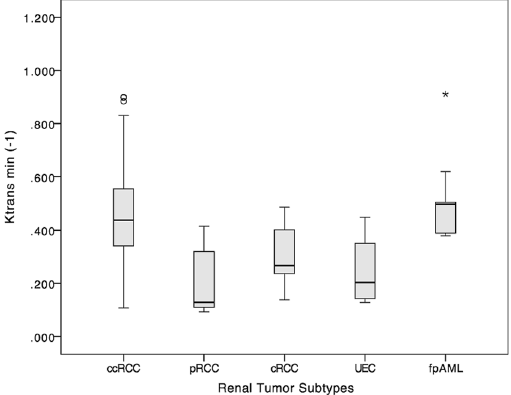
Figure 3. Box-and-whisker plot of K trans value. Boxes = interquartile range, whiskers = range of all values, horizontal line within box = median K trans , ccRCC = clear cell RCC, pRCC = papillary RCC,